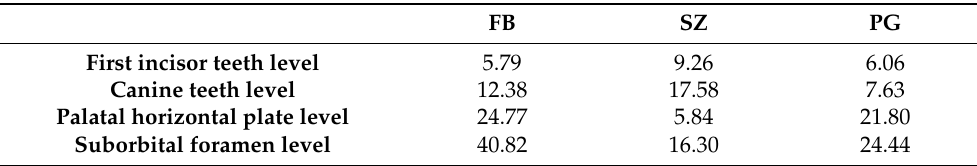
Table 1. Median AA/NC ratios in four planes